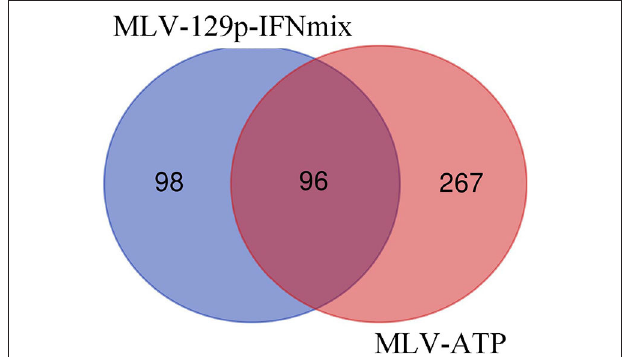
FIGURE 1 | Venn diagram of statistically significant gene lists for MLV-129p-IFNmix and MLV-ATP vs. Sham-PRRSV. Genes were considered significant with FDR of ≤ 0.1.